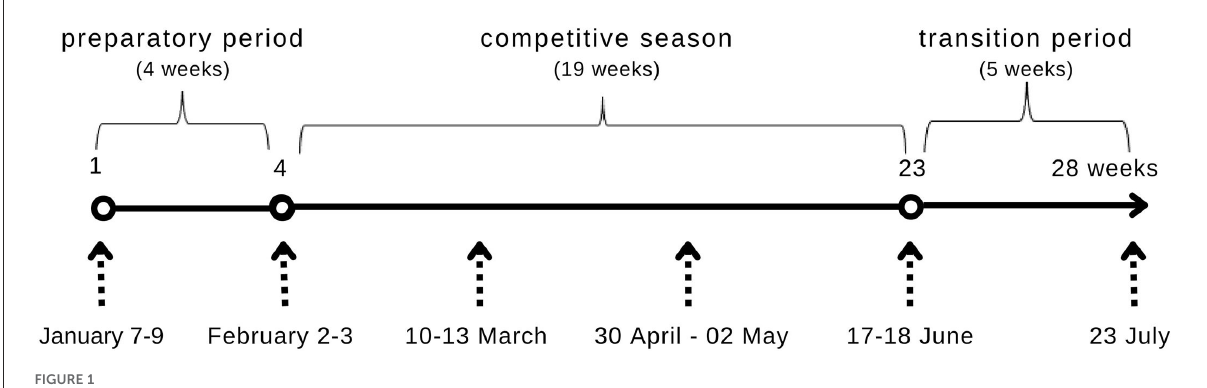
FIGURE1 Procedure for the anthropometric